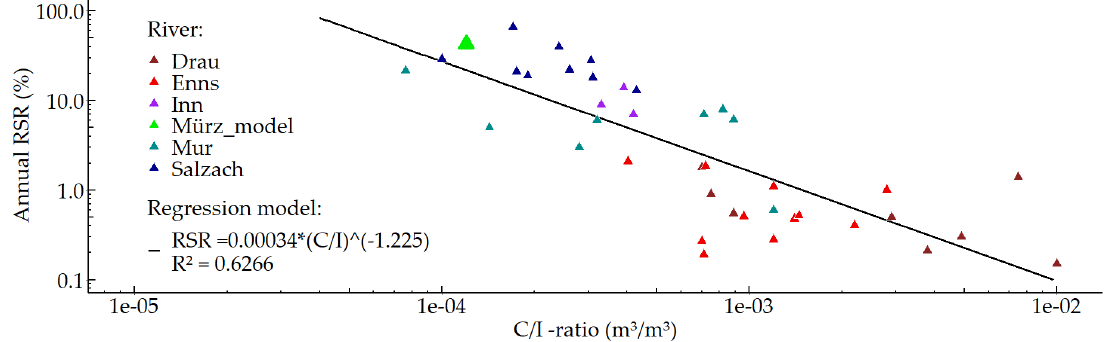
Figure 10. Reservoir sedimentation in Austria, field data and model results. Field data provided by [10,19].